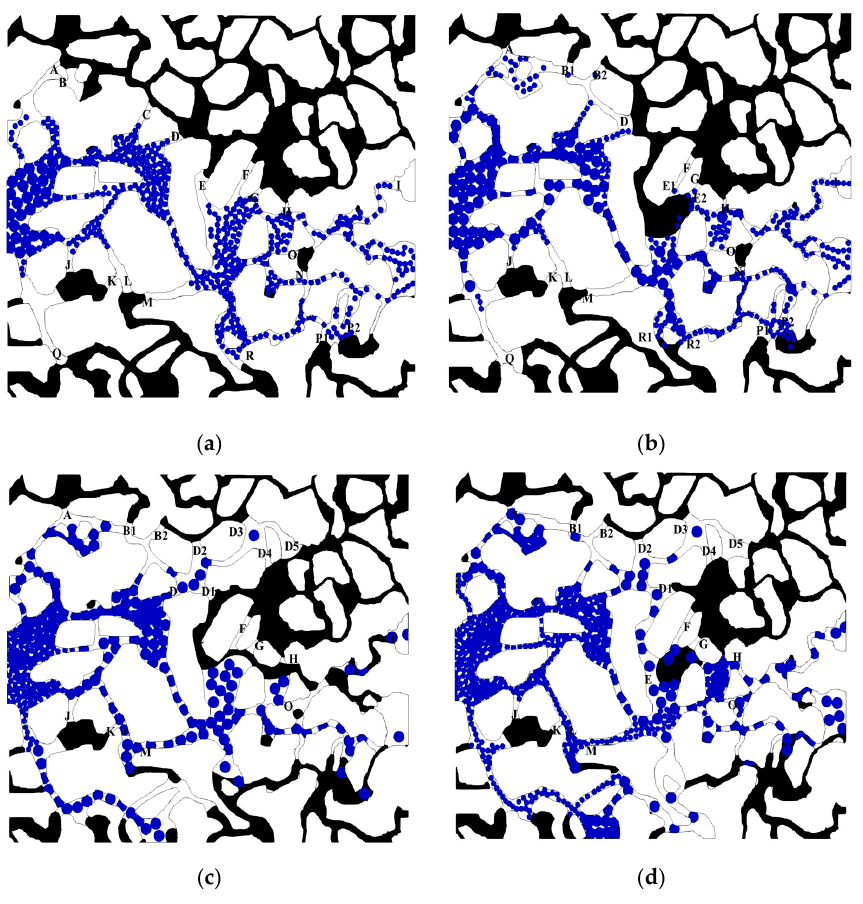
Figure 10. Particle–oil–water distribution at different times in case III (alternate injection) and case